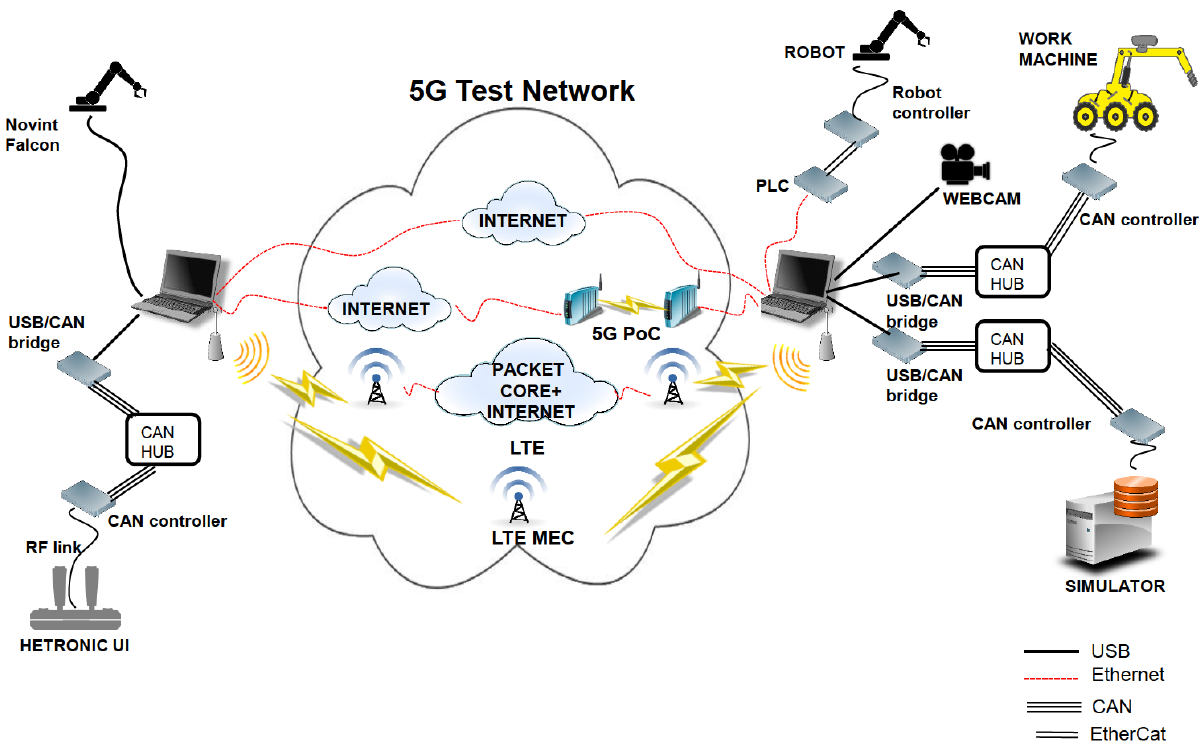
Figure 1: Test network based on 5G technologies and interfacing to users and controlled machinery.